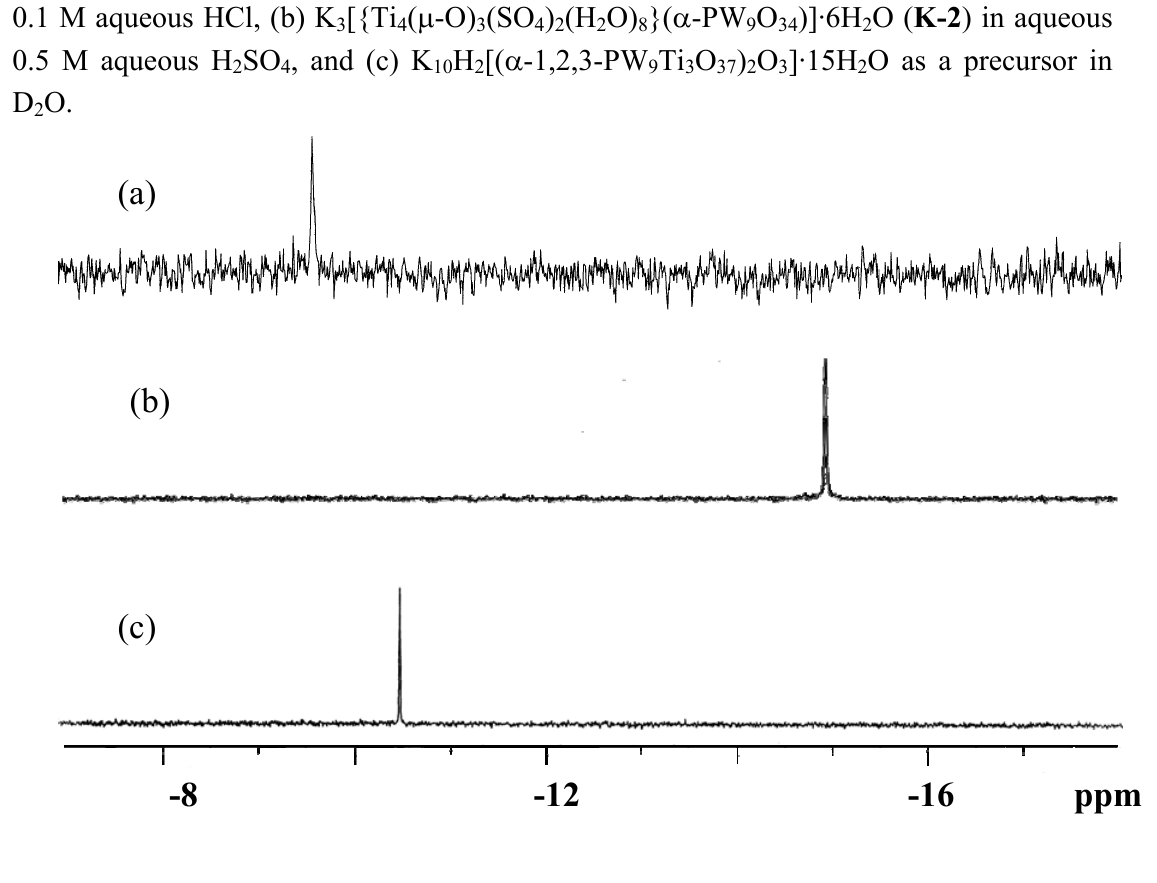
(SO ) (H O) }( α -PW 3 4 2 2 8